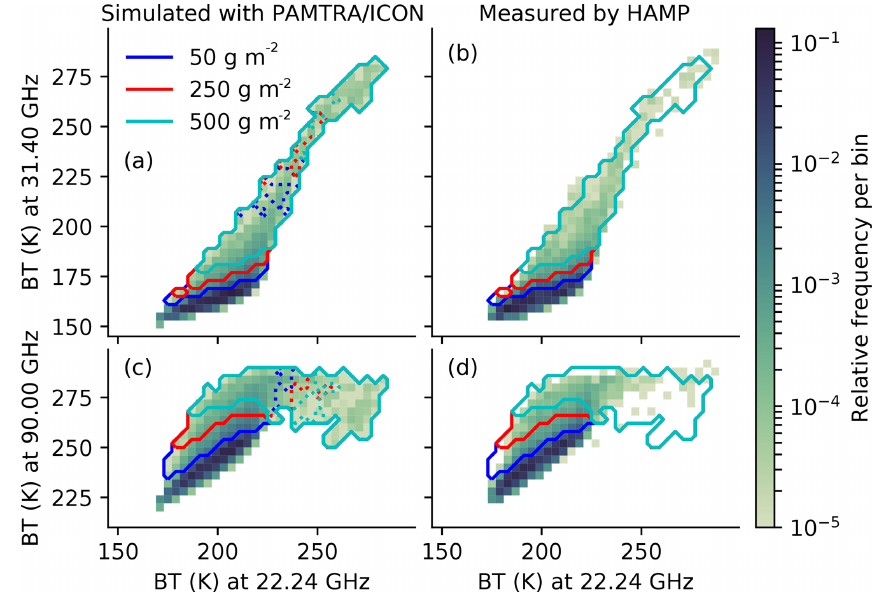
Figure 3. Relation between brightness temperatures (BT) in an absorption channel (22.24GHz) and two window channels, i.e., 31.40GHz (a, b) and 90.00GHz (c, d) . Two-dimensional histograms of occurrences in simulations (a, c) and HAMP measurements (b, d) . Solid contours highlight BT combinations in simulations that mostly occur with LWP higher than 50, 250, and 500gm − 2 . Dotted lines highlight combina- tions of which RWP mostly exceeds the respective threshold. LWP contours in (b) and (d) are taken from (a) and (c) for guidance. HAMP data from all NARVAL2 flights and ICON–PAMTRA data of the corresponding dates are used. Profiles and measurements with ice are